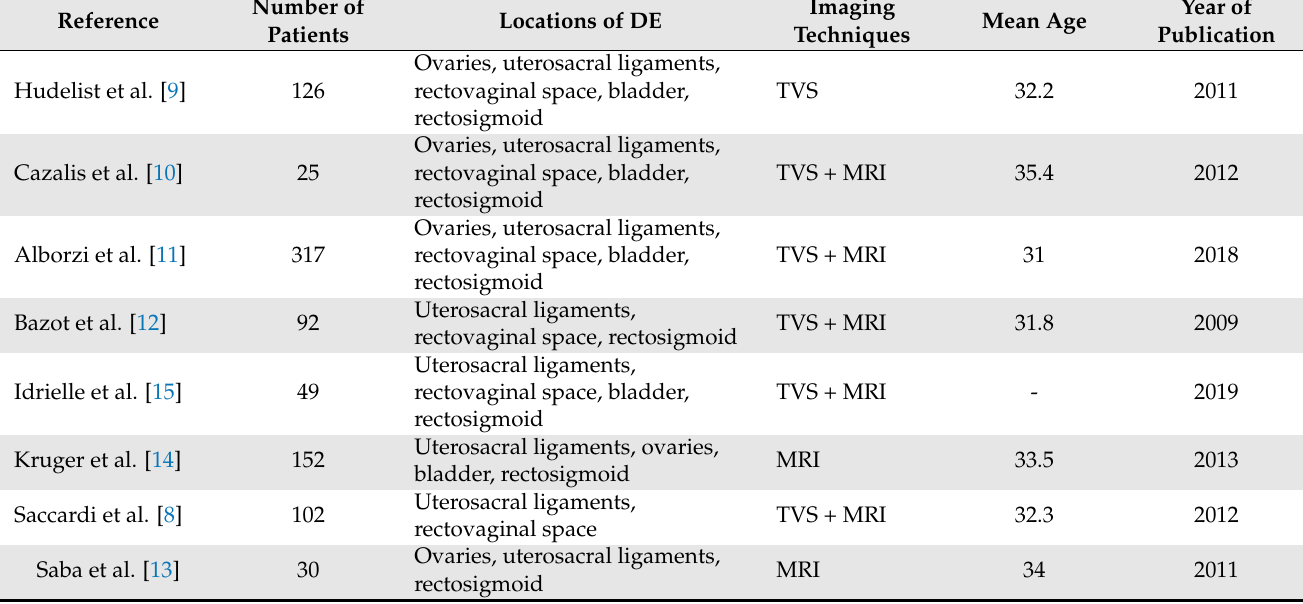
Table 1. Comparison between the diagnostic accuracy of transvaginal sonography and magnetic resonance imaging in DE as reported in different studies.